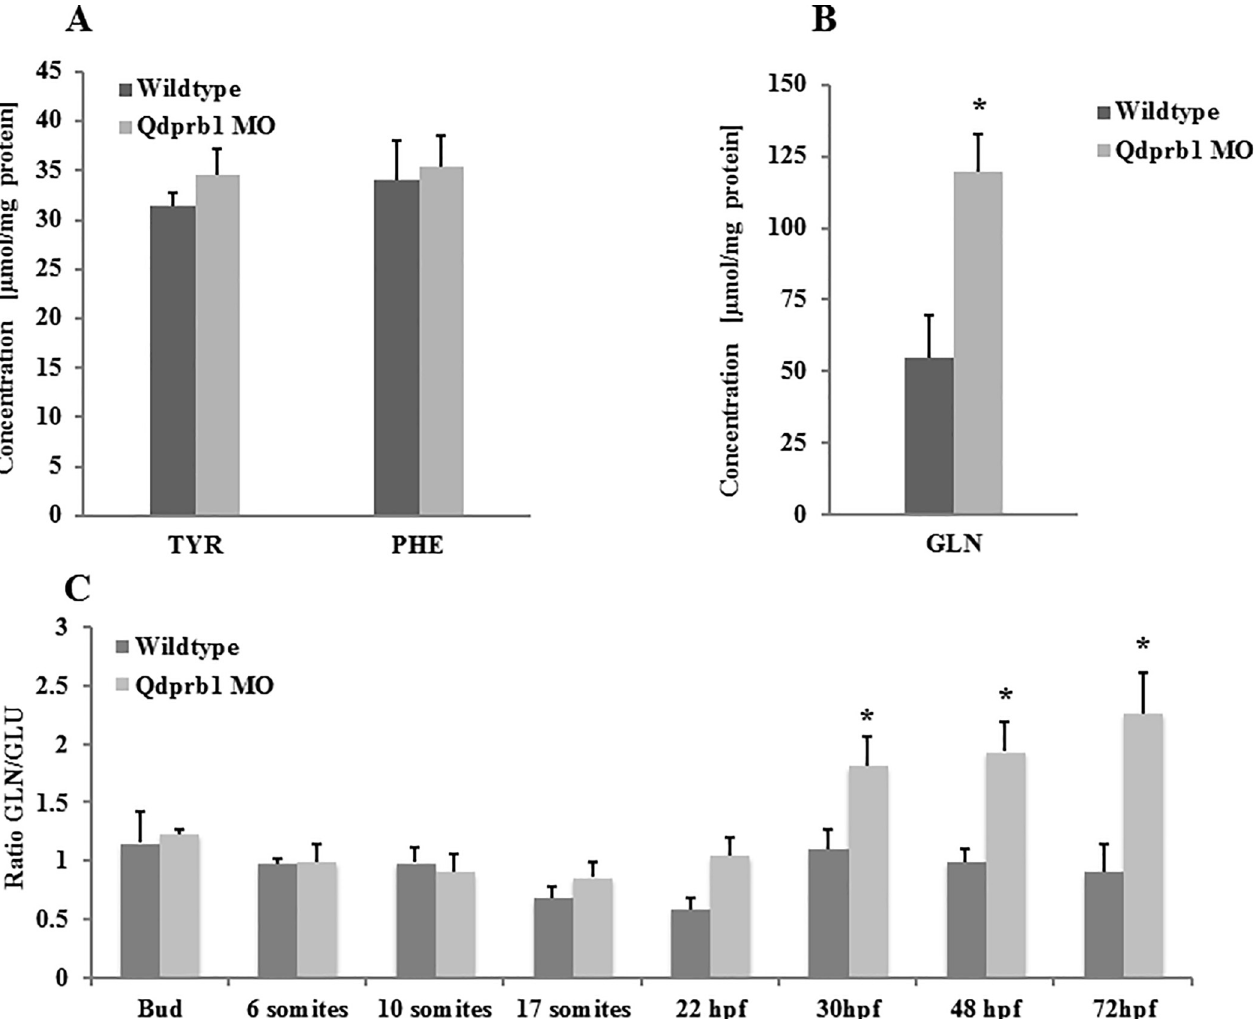
Fig 3. Biochemical analysis of Qdprb1 hypomorphic embryos. Amino acid analysis at 72 hpf shows reduced phenylalanine and unchanged tyrosine levels upon (A) as well as a strong increase of glutamine content (B) upon qdprb1 knockdown. (C) Ratio of glutamine over glutamate in Qdprb1 hypomorphic embryos remains unchanged during gastrulation and early segmentation, but it starts increasing at the onset of the observed morphological phenotype (18 hpf) coinciding with the start of neuro- and gliogenesis. This pattern is not found in wildtype